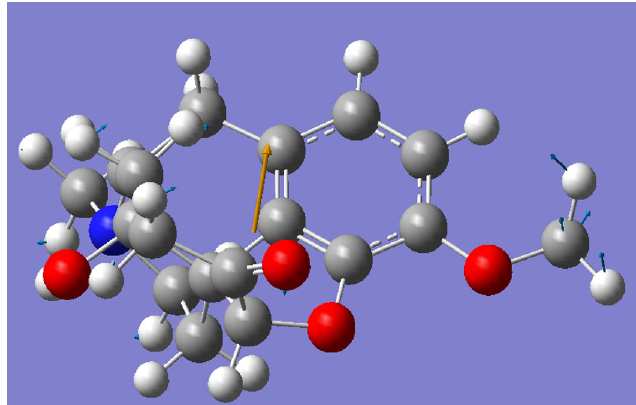
Figure 4. Oxycodone, the lowest 1.358 THz normal mode. A view of atomic motions (blue arrows) and dipole moment derivative (brown arrow).